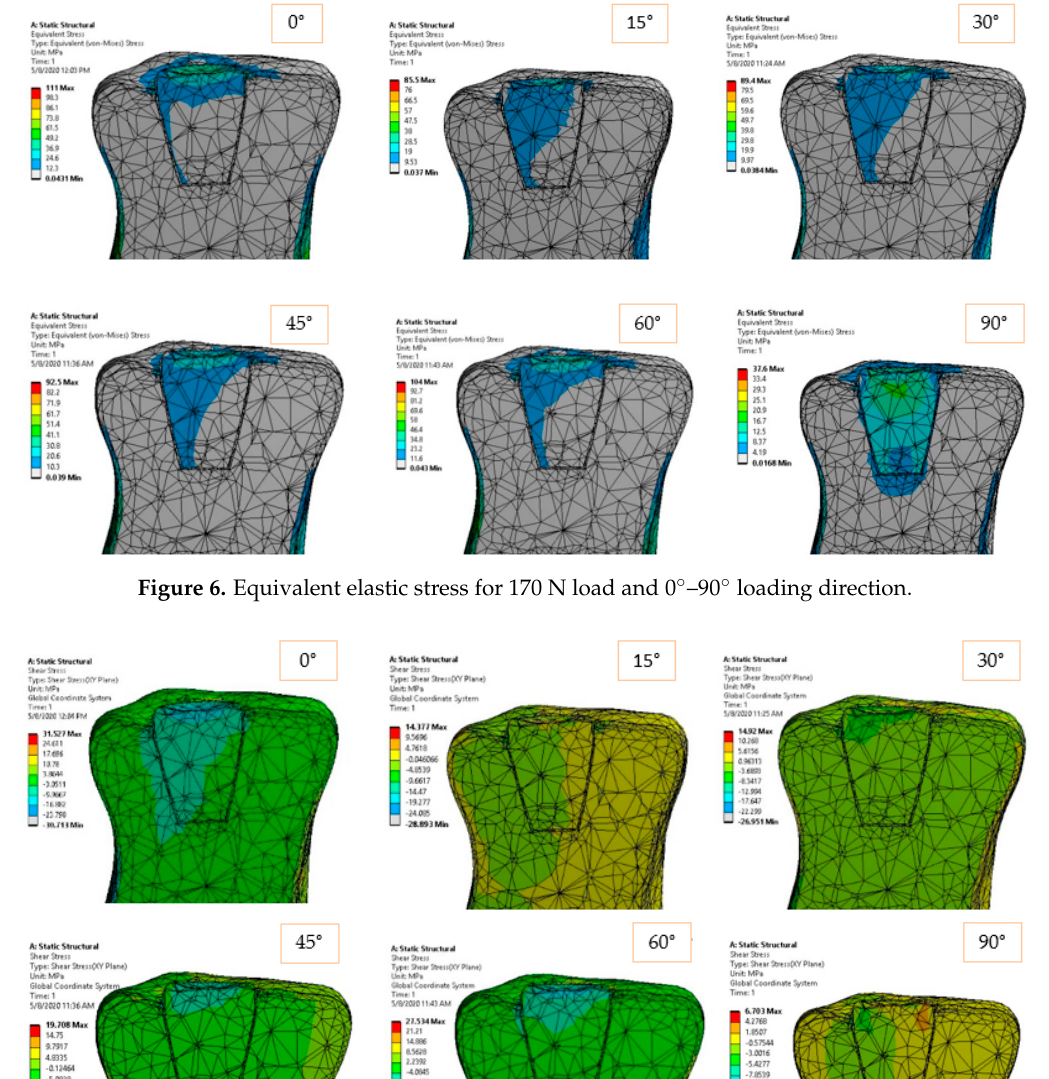
Figure 7. Shear stress in XY plane for 170 N load and 0°–90° loading direction.